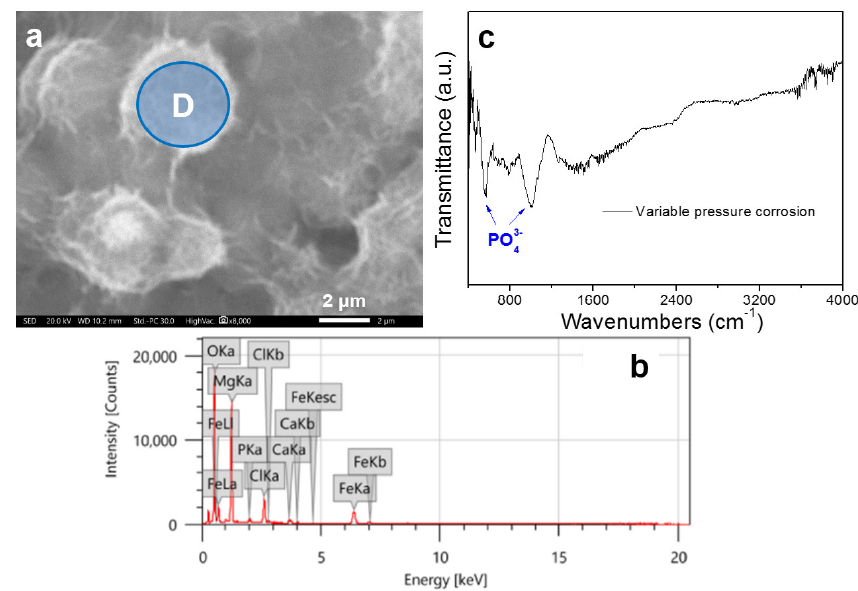
Figure 5. ( a ) Highly magnified SEM image of Sample 8; ( b ) EDS analysis of area D in ( a ); ( c ) superficial FTIR analysis of Sample 8.